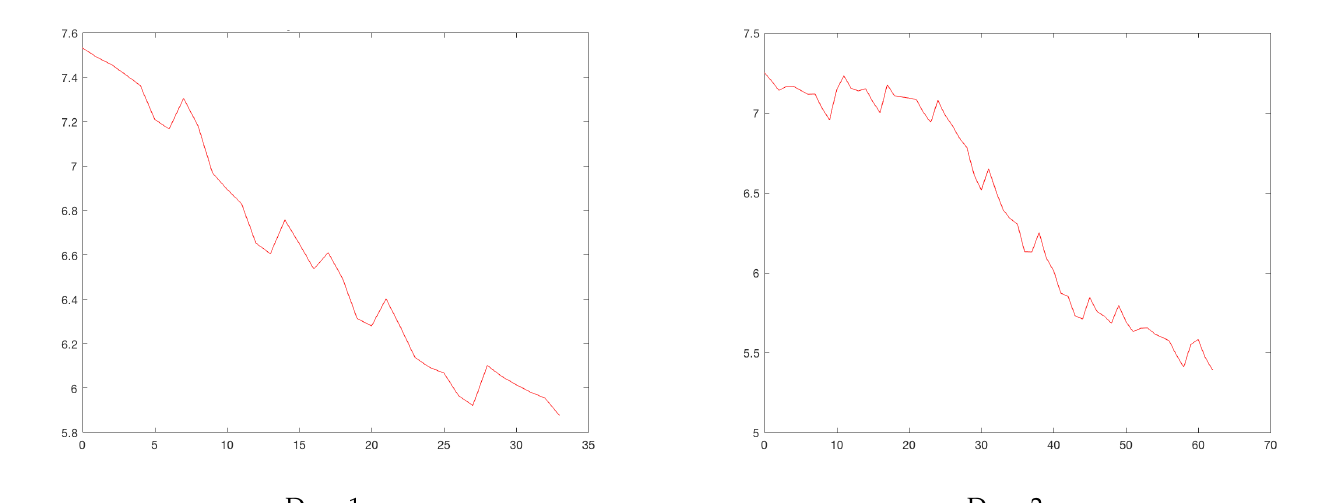
Figure A17. Marseille’s drops. Horizontal axis, days; vertical axis: logarithm of daily